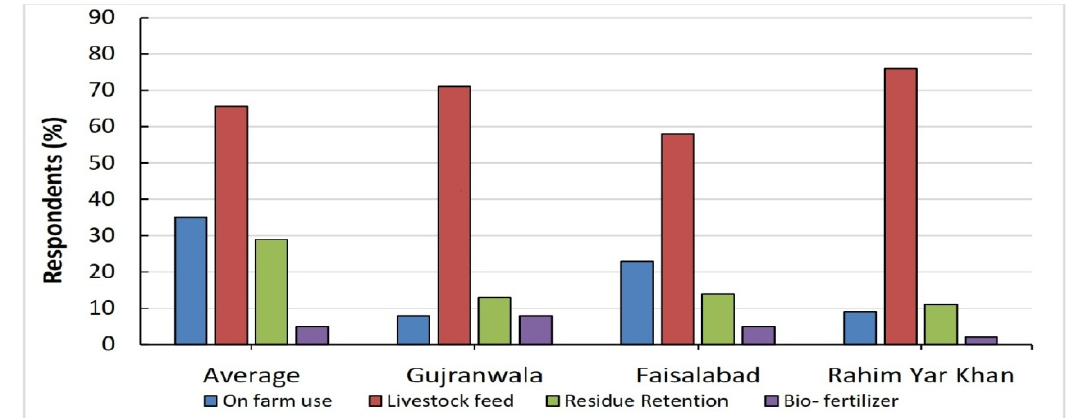
Figure 4. Farmers’ residue management practices in three Punjab districts.